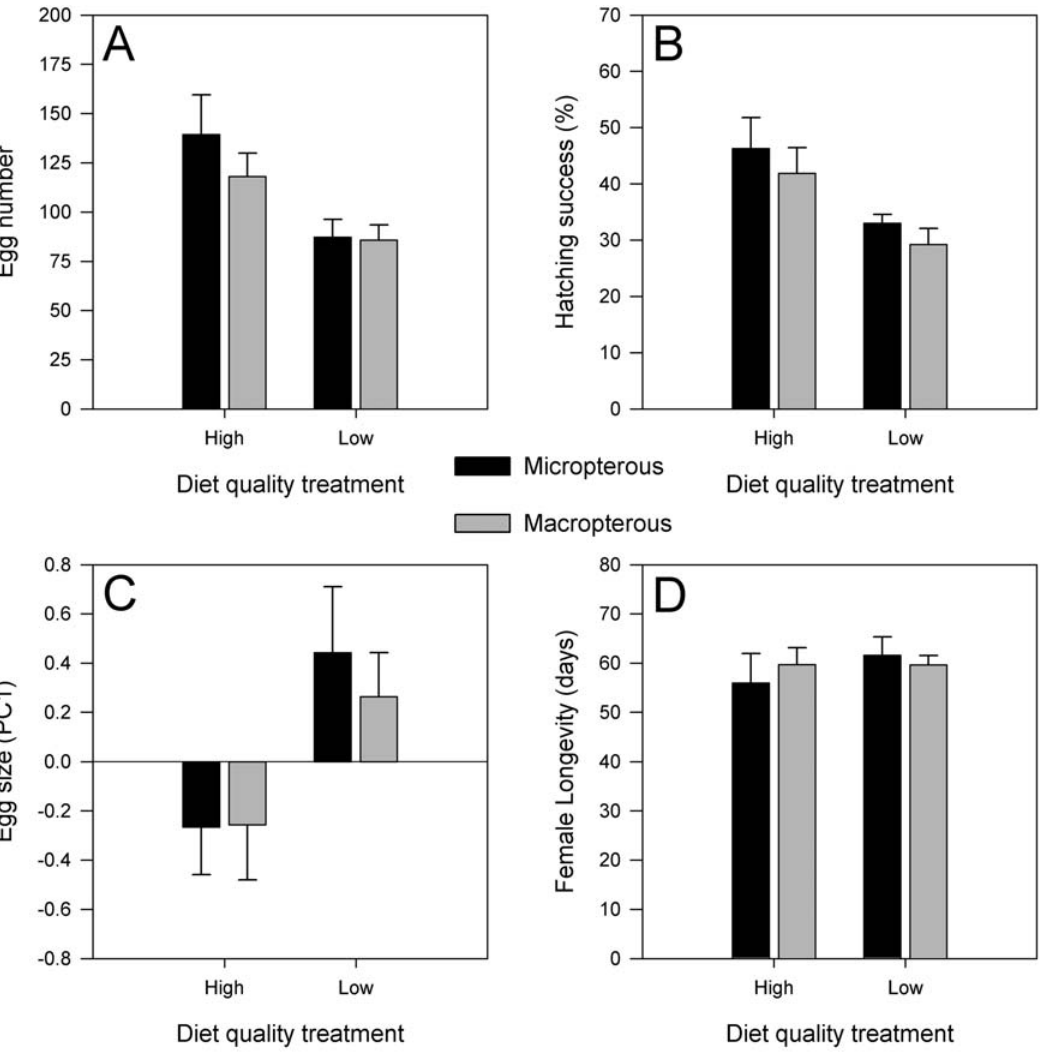
Figure 2. The effect of diet quality treatment and wing morph type on female reproductive investment. The means and standard errors for the diet treatment and wing morph factors are calculated based on the average values for each of the experimental populations.